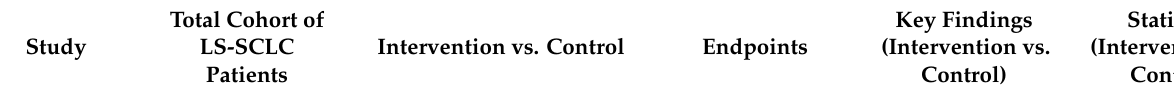
Table 1. Studies that evaluated the optimal dose and fractionation regimen for LS-SCLC patients with study information and key